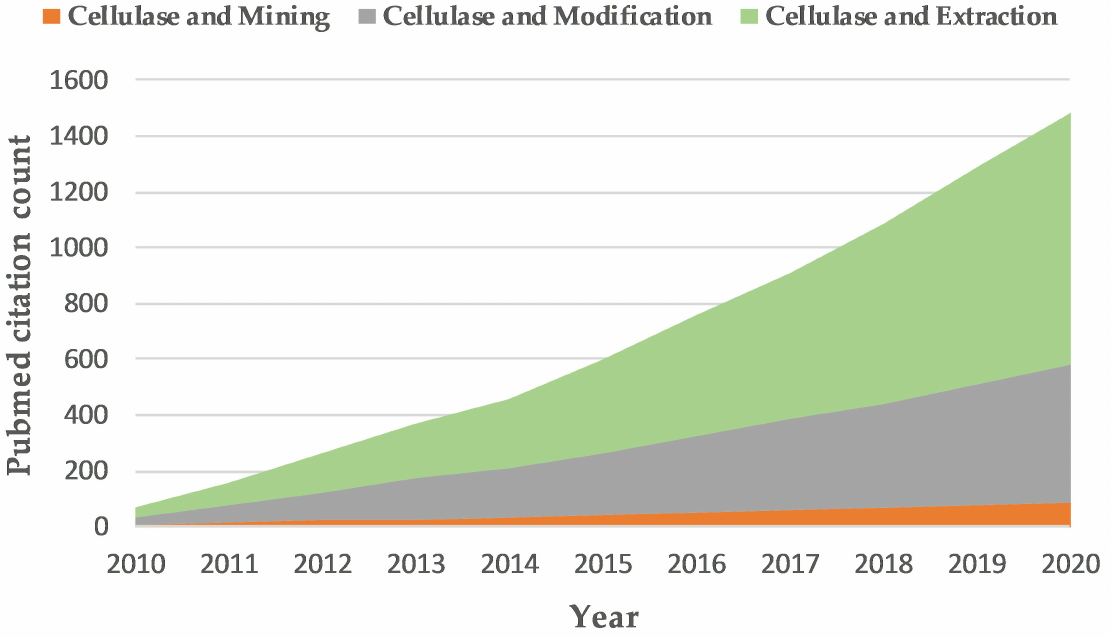
Figure 2. PubMed citation count of cellulase research by